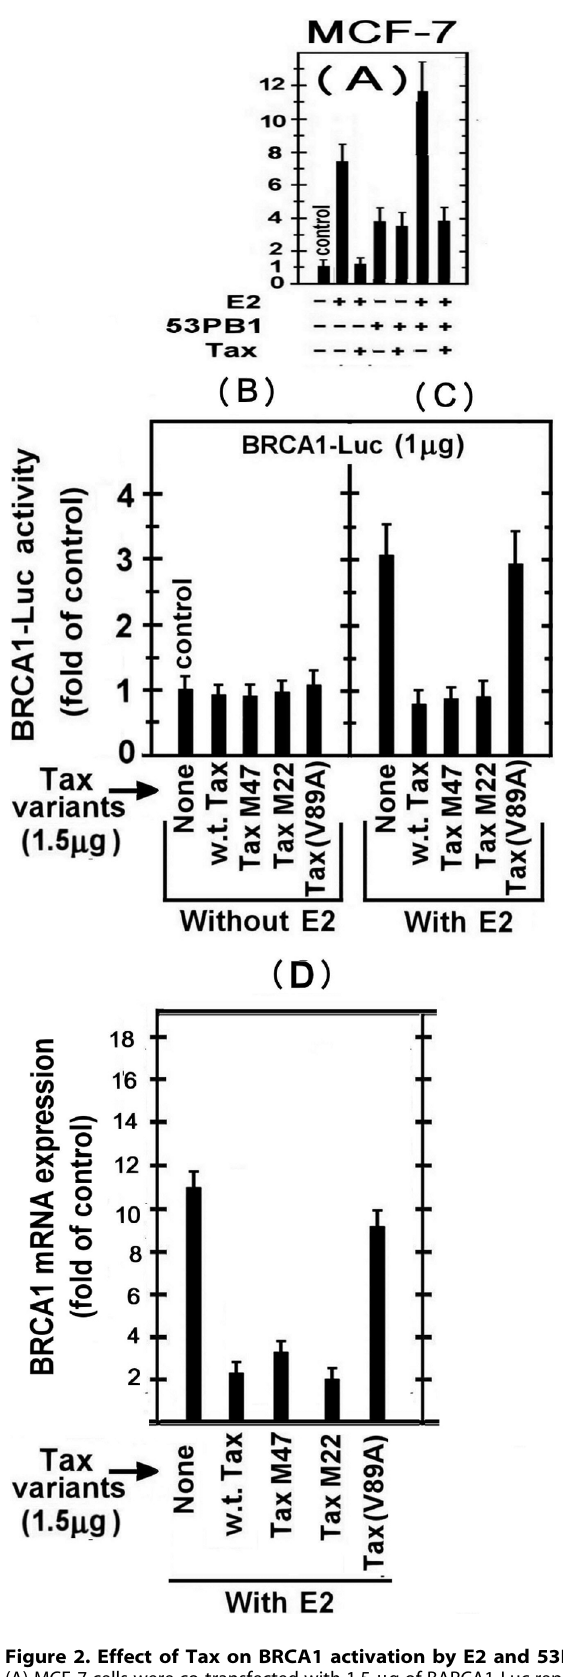
Figure 2. Effect of Tax on BRCA1 activation by E2 and 53PB1. (A) MCF-7 cells were co-transfected with 1.5 m g of BARCA1-Luc